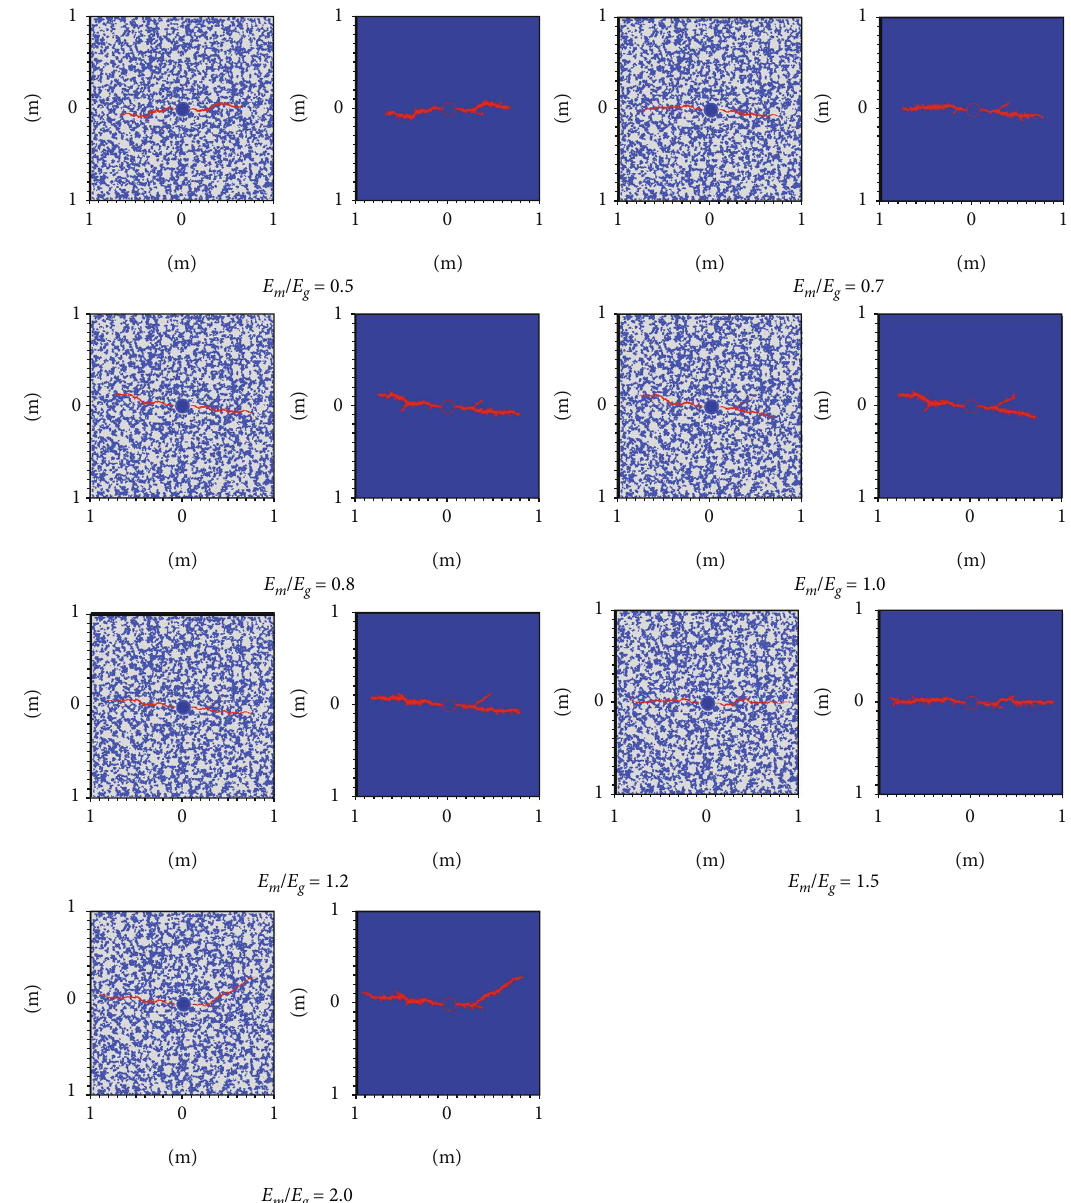
Figure 9: HF propagation morphology under di ff erent ratios of the elastic modulus of the matrix to